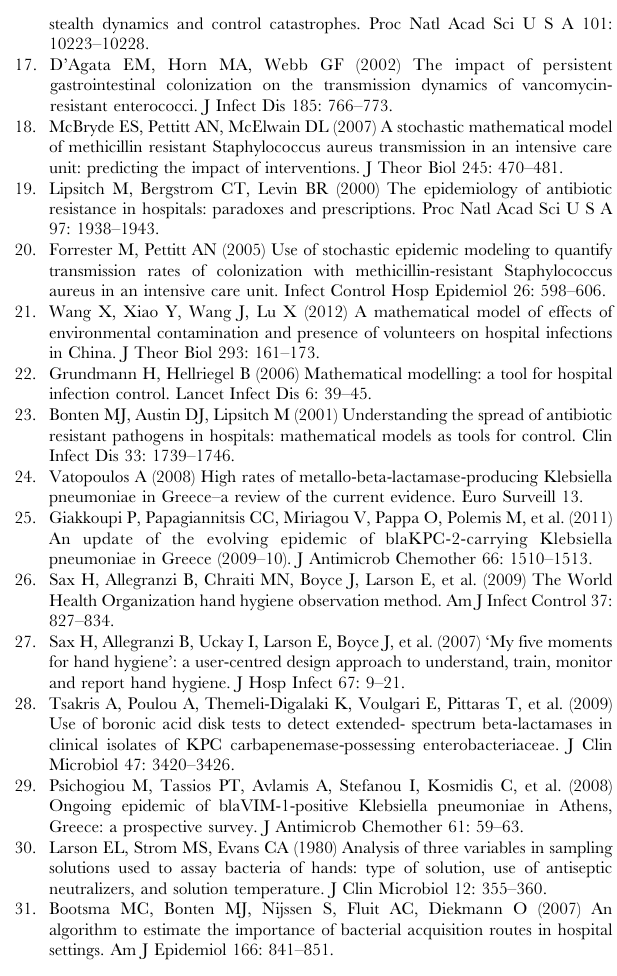
Figure S1 Distribution of the number of colonized patients per day. The dispersion parameter (variance/mean) is 1.20 indicating that cross-transmission is the main route of CPKP acquisition within the unit. (TIF) Figure S2 Prediction of the effective reproduction number R(p) of CPKP at different levels of hand washing compliance ( p ) assuming an R 0 of 2. Values of R(p) . 1 (i.e. above the dotted line) indicate the potential for an epidemic to occur. The threshold hand hygiene compliance for R(p) , 1 is 50% (black line). The red and blue lines depict R(p) at different levels of hand washing compliance under a 20% or 40% reduction, respectively, in the duration of antibiotic usage during patients’ stay in the unit (assuming a relative risk associated with antibiotic use equal to 3). In the presence of these antibiotic restriction policies, the threshold hand hygiene compliance for R(p) , 1 is estimated 45.6% and 40.5%, respectively.